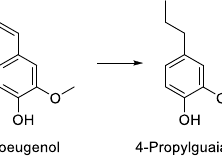
Figure 5. Mononuclear products observed for catalytic hydrogenolysis of kraft lignin in methanol with Pt/C at subcritical (200 °C, 76 bar, left ), near-critical (235 °C, 110 bar, middle ), and supercritical (250 °C, 131 bar, right ) conditions; (1) 4-ethyl-2,6-dimethoxyphenol or isomer.